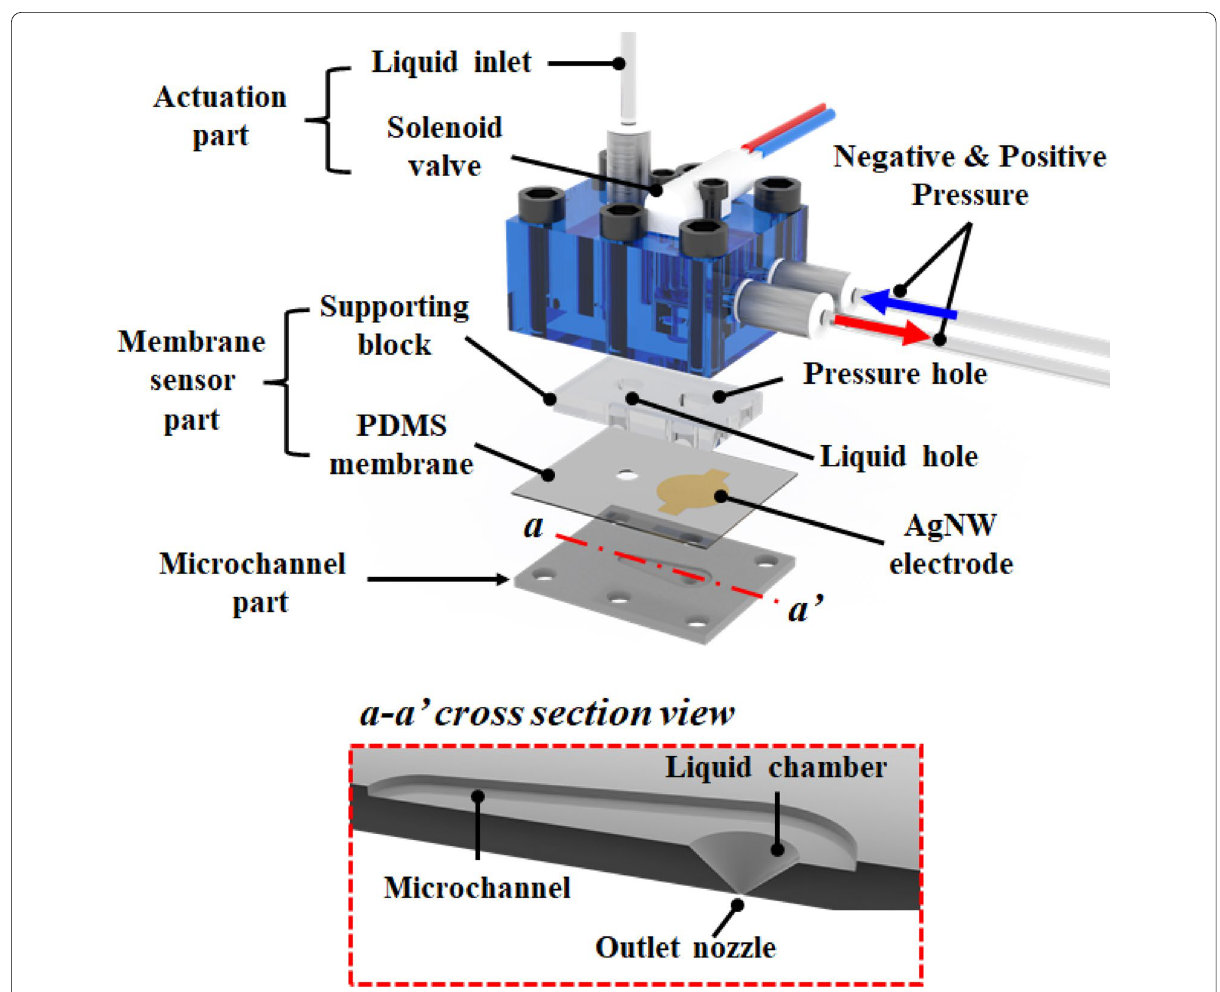
Fig. 1 Schematic of the configuration of a pneumatic dispenser capable of monitoring droplet